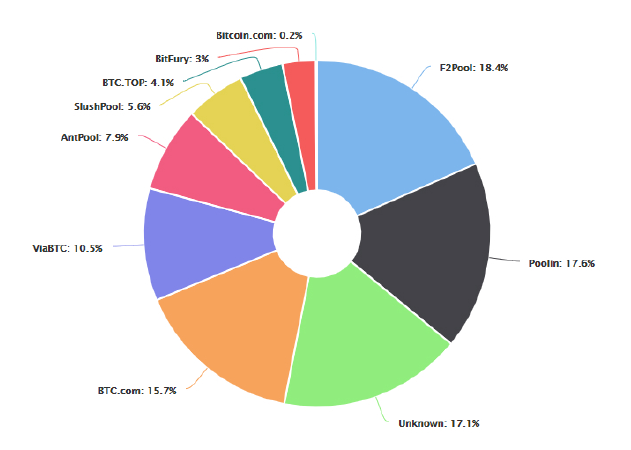
Figure 6. Blocks Mined by Top Pools according to market share, October 2019, Source: